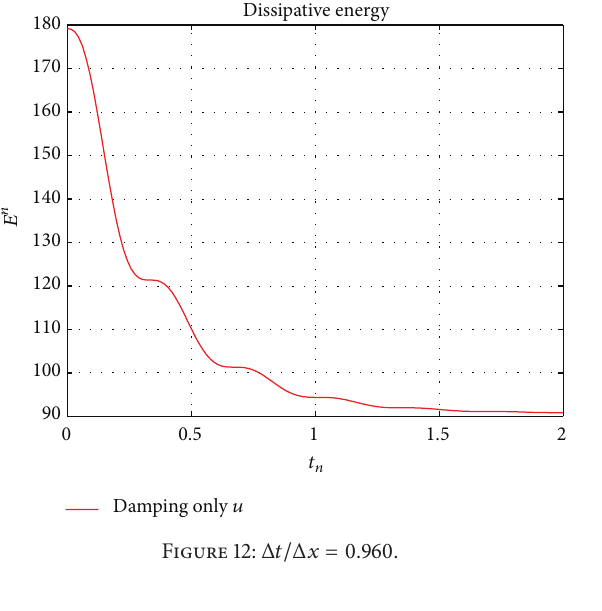
Figure 14: Δ𝑡/Δ𝑥 = 0.8960 .